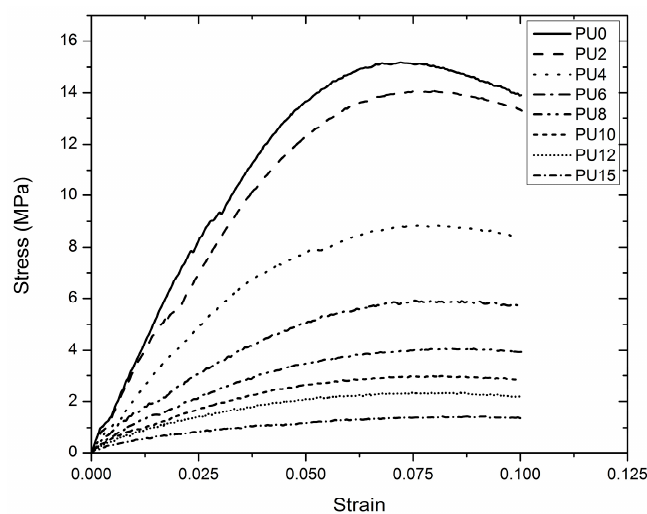
Figure 11. Flexural stress–strain behavior of the all types of PU, (PU0–PU10 are types of PU and PU6—PU which contained 6% PEG).